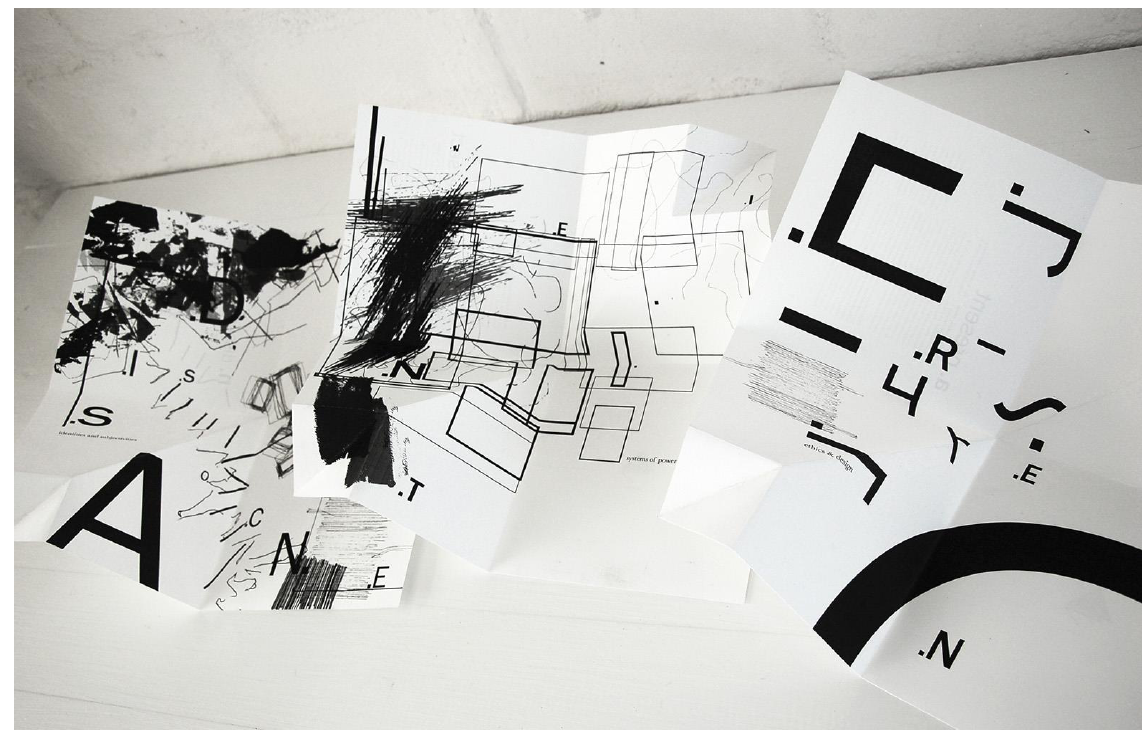
Figure 2.3 : Project 2: Mapping meaning through typographic play (Source: Emma,